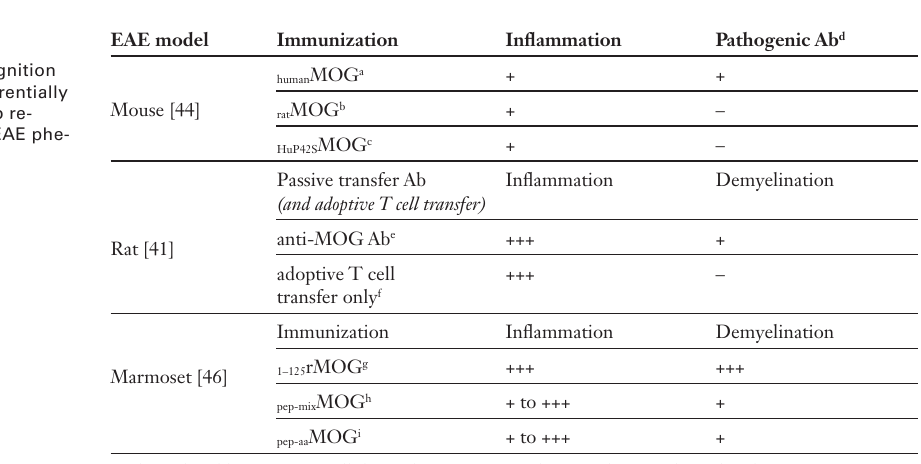
Table 1 Epitope recognition of MOG differentially influences Ab re- sponse and EAE phe- notype.